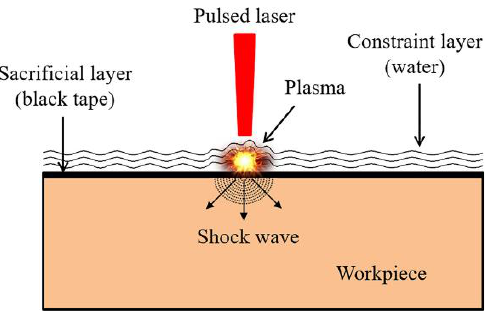
Figure 1. Illustration of LSP treatment. Reprinted with permission from Ref. [14]. Copyright 2021 Elsevier.